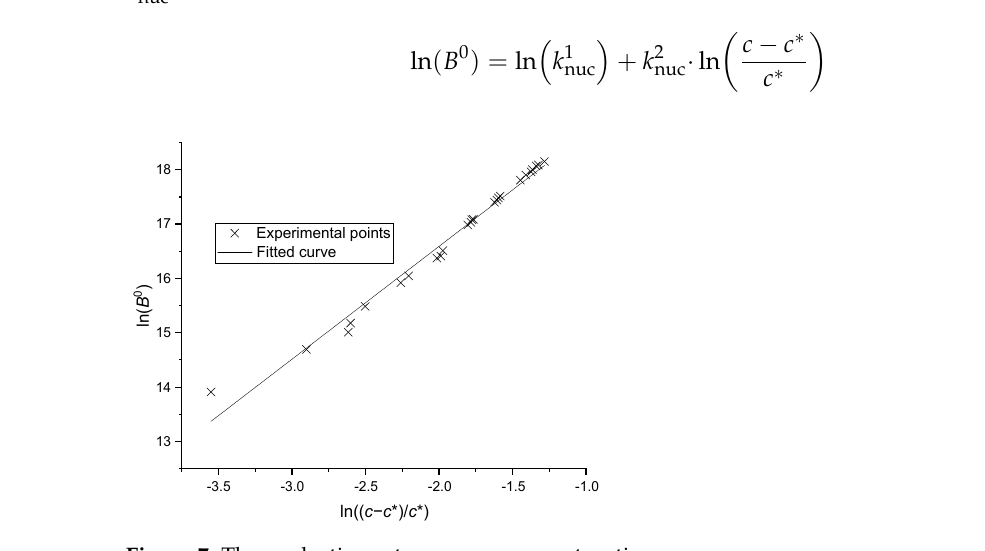
Figure 7. The nucleation rates versus supersaturations.